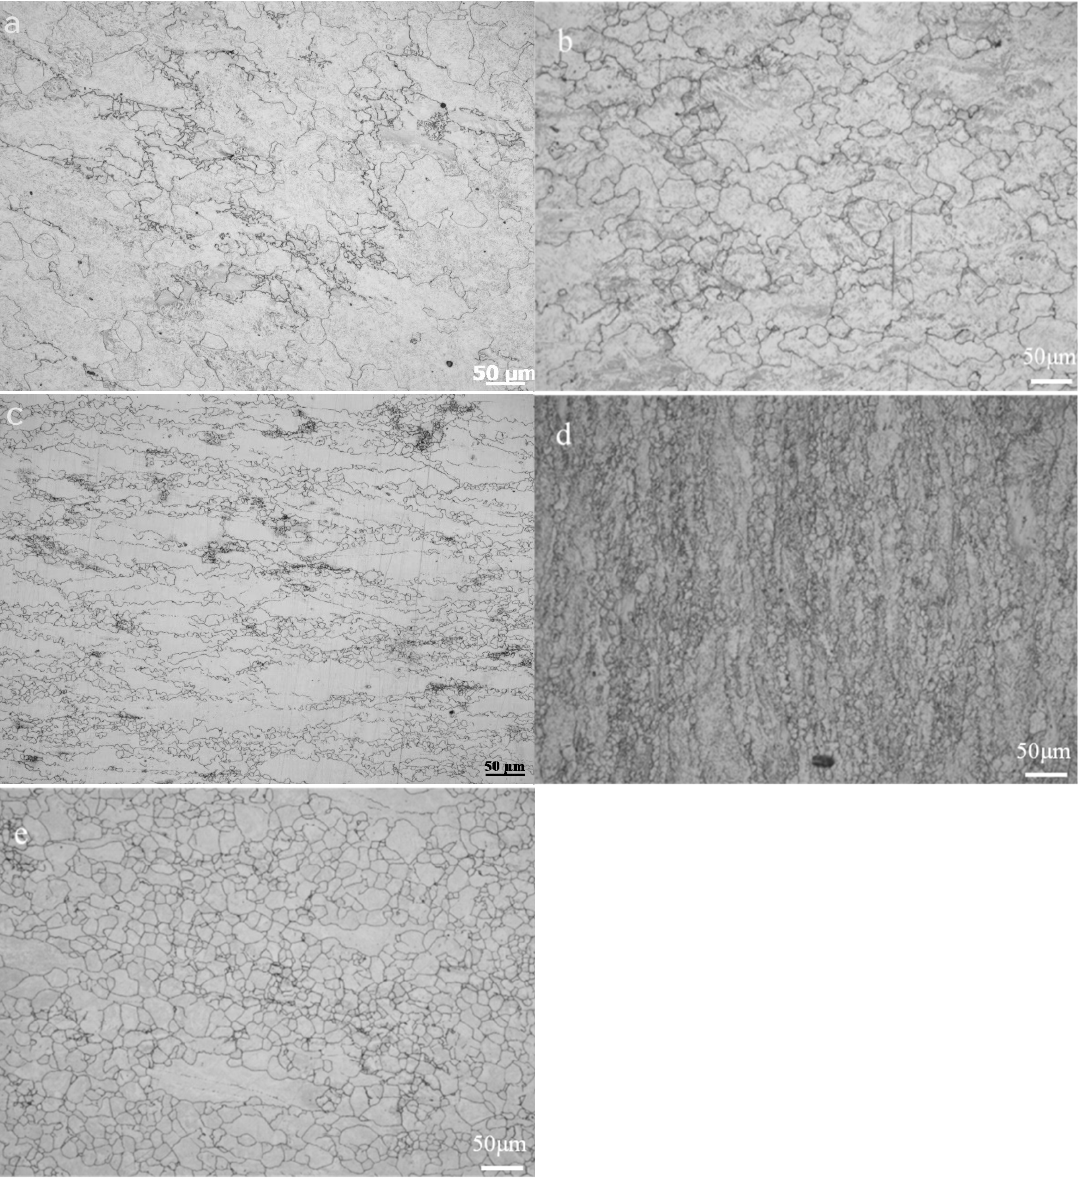
Figure 8. Microstructures at a deformation temperature of 1050 °C and at different deformation rates: ( a ) 0.001 s − 1 , ( b ) 0.01 s − 1 , ( c ) 0.1 s − 1 , ( d ) 1 s − 1 , and ( e ) 10 s − 1 . Average grain sizes: ( a ) 200 μ m, ( b ) 110 μ m, ( c ) 80 μ m, ( d ) 50 μ m, and ( e ) 20 μ m.